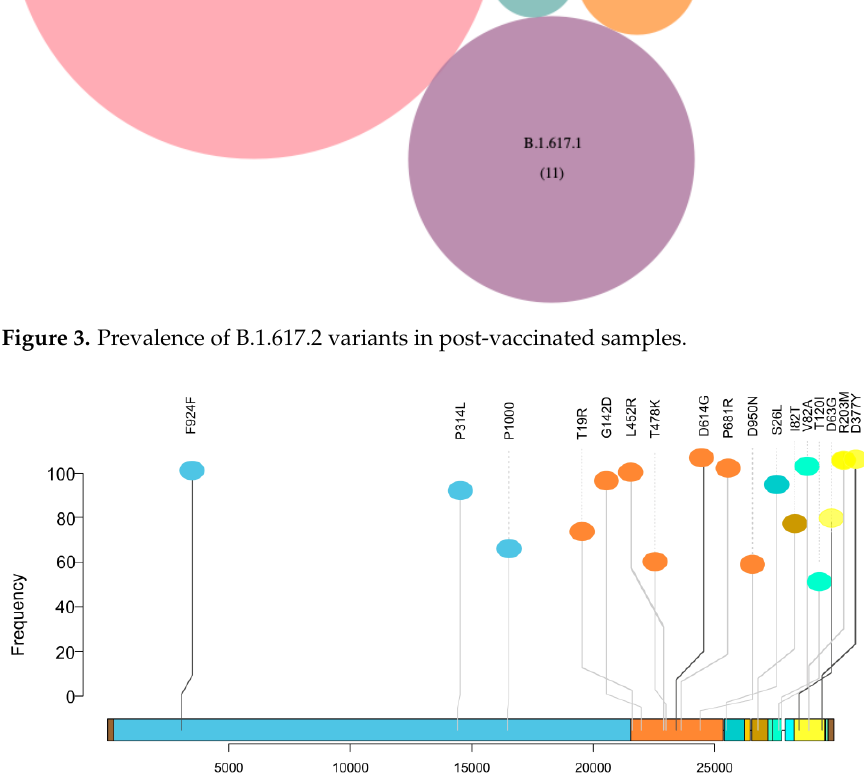
Figure 4. Top most frequent mutations detected in 46 vaccine-breakthrough samples.